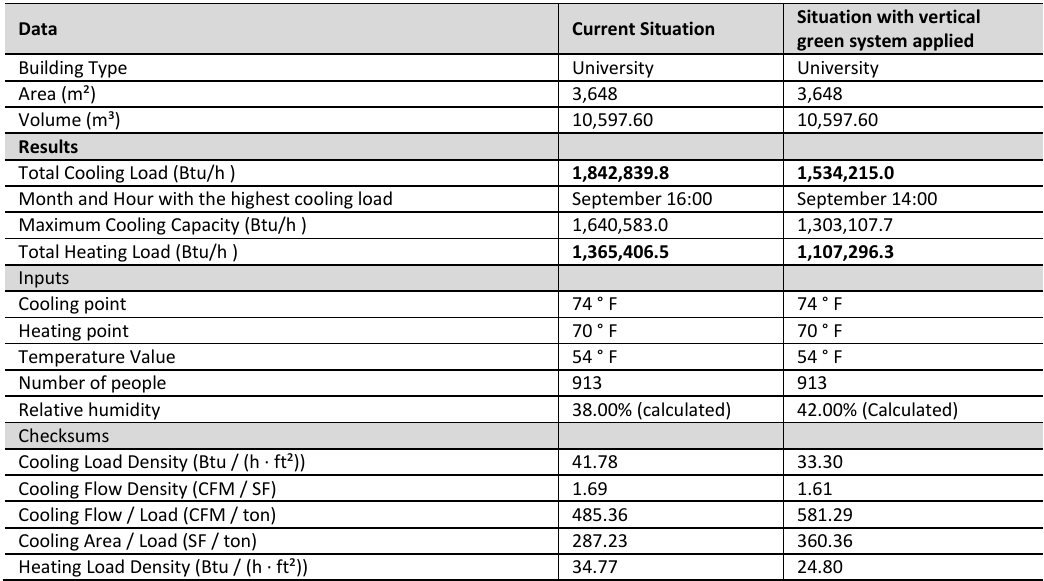
Table 12 Heating, cooling load analysis comparison table of the Faculty of Economics and Administrative Sciences,